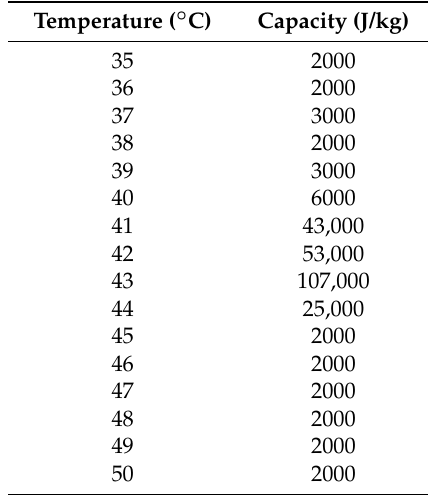
Table 3. Heat capacity of PCM at different temperatures [16].